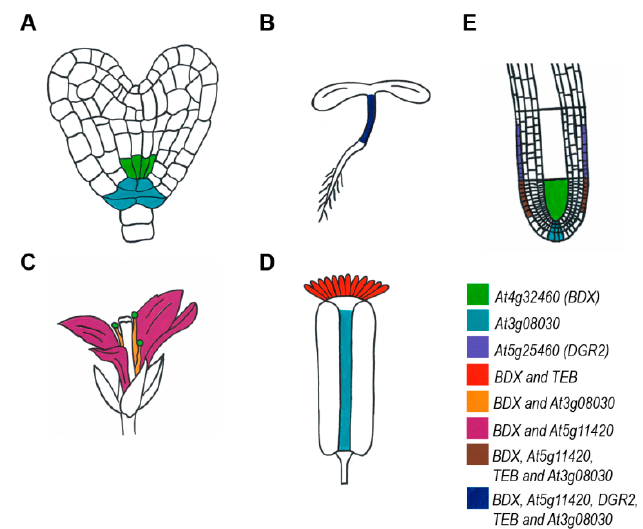
Figure 1. Expression patterns of the DUF642 genes described to date using reporter genes during 92 Arabidopsis plant development. 93